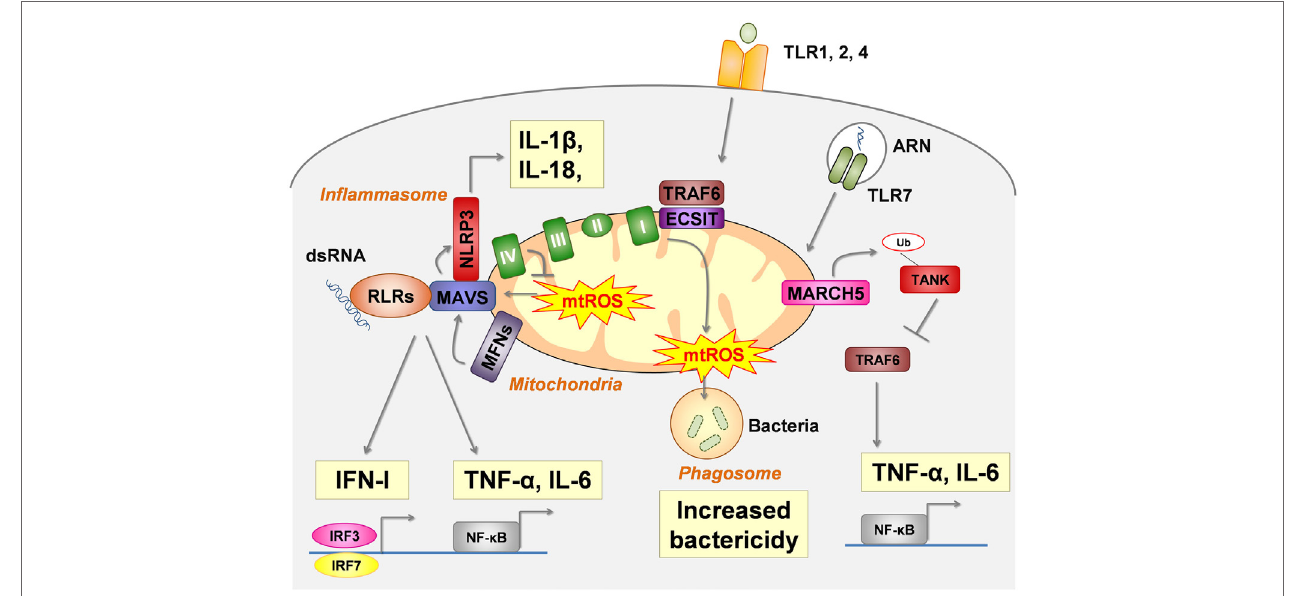
FiGURe 1 | Mitochondria are a platform for pattern recognition receptors (PRRs) signal transduction and regulation. In intact cells, intracellular signaling pathways of several critical PRRs physically interact with mitochondria to act as a modulator. RIG-I-like receptors (RLRs) (retinoic acid- inducible gene I and melanoma differentiation-associated protein 5 MDA5) signals are dependent of MAVS, the activation of which (oligomerization) is enhanced by mtROS and mitochondrial fusion [regulated by mitofusin (MFN) 1 and MFN2]. NLRP3-inflammasome assembly also interacts with MAVS for proper activation. Moreover, mtROS and several mtDAMPs activate the NLRP3-inflammasome (see Figure 2 ). Toll-like receptor (TLR) 1, TLR2, and TLR4 ligation leads to the enrichment of TRAF6 and Evolutionarily Conserved Signaling Intermediate In Toll Pathway (ECSIT) (a complex I–assembly factor) at the mitochondrial periphery and subsequent recruitment of mitochondria to macrophage phagosomes were they produce mtROS. TLR7 signaling involves the mitochondrial protein membrane-associated ring-CH-type finger 5 (MARCH5), which catalyzes the polyubiquitination and degradation of TANK a repressor of TLR7 signaling